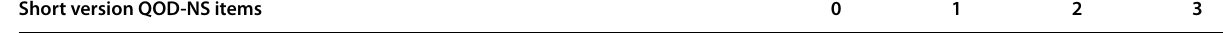
Table 1 Short version of Questionnaire of Olfactory Disorders-Negative Statements of patient Short version QOD-NS